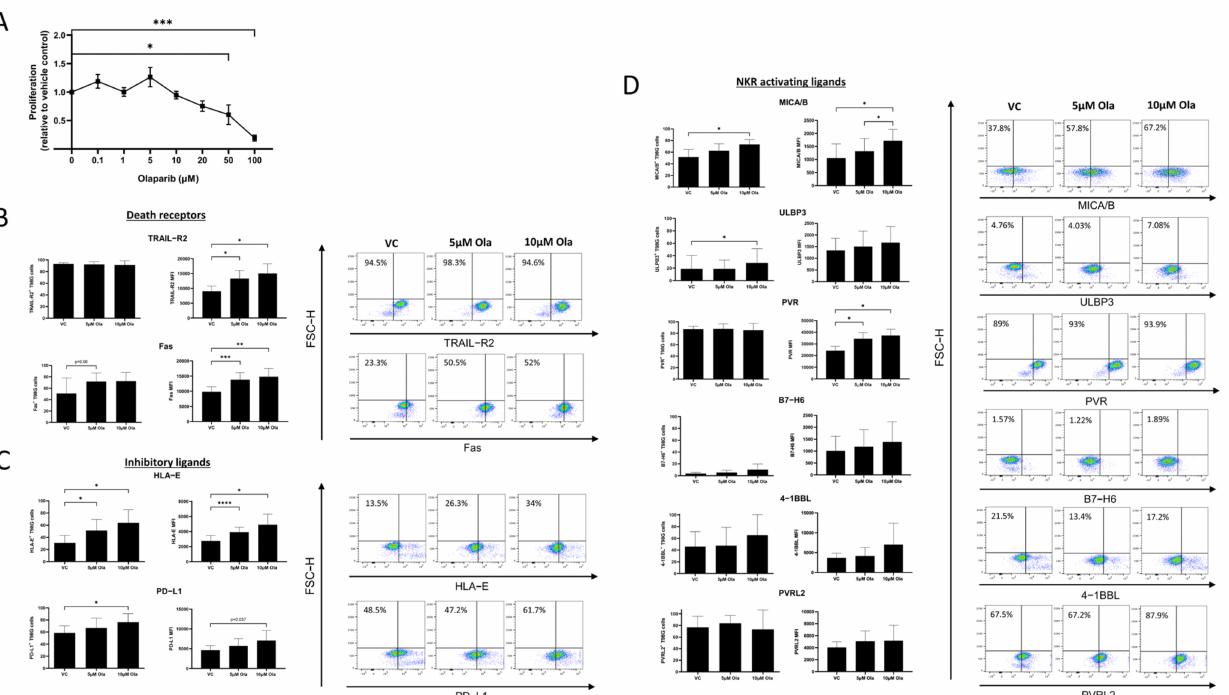
Figure 2. Olaparib treatment significantly alters natural killer receptor ligand surface expression and death receptor expression by T98G cells. ( A ) Line graph showing the proliferation of T98G cells following treatment with 0.1 µ M, 1 µ M, 5 µ M, 10 µ M, 20 µ M, 50 µ M, and 100 µ M of Olaparib for 24 h ( n = 4). ( B ) (Left) Bar charts showing the MFI and % frequencies of T98G cells positive for death receptor expression following treatment with 5 µ M or 10 µ M of Olaparib for 24 h [TRAIL-R2 (top, n = 4); Fas (bottom, n = 5)]. (Right) Representative dot plots showing % frequencies of death receptor-expressing T98G cells following treatment with 5 µ M or 10 µ M of Olaparib for 24 h. ( C ) (Left) Bar charts showing the MFI and % frequencies of T98G cells positive for inhibitory ligand expression following treatment with 5 µ M or 10 µ M of Olaparib for 24 h [HLA-E (top, n = 4); PD-L1 (bottom, n = 5)]. (Right) Representative dot plots showing % frequencies of inhibitory receptor-expressing T98G cells following treatment with 5 µ M or 10 µ M of Olaparib for 24 h. ( D ) (Left) Bar charts showing the MFI and % frequencies of T98G cells positive for NKR-activating ligand expression following treatment with 5 µ M or 10 µ M of Olaparib for 24 h [MICA/B, ULBP3, B7-H6 ( n = 5); PVR, 4-1BBL, PVRL2 ( n = 4)]. (Right) Representative dot plots showing % frequencies of NKR-activating ligand-expressing T98G cells following treatment with 5 µ M or 10 µ M of Olaparib for 24 h. * p < 0.05, ** p < 0.01, *** p < 0.001, **** p < 0.0001 by one-way ANOVA with post hoc Dunn’s test. Frequencies of NKp46 + , DNAM-1 + , CD69 + , NKG2A + , PD-1 + , TIGIT + , TRAIL + , FasL + , CD107a + , CD16 + , Granzyme B + , CD27 + , and CD57 + NK cells remained unaltered